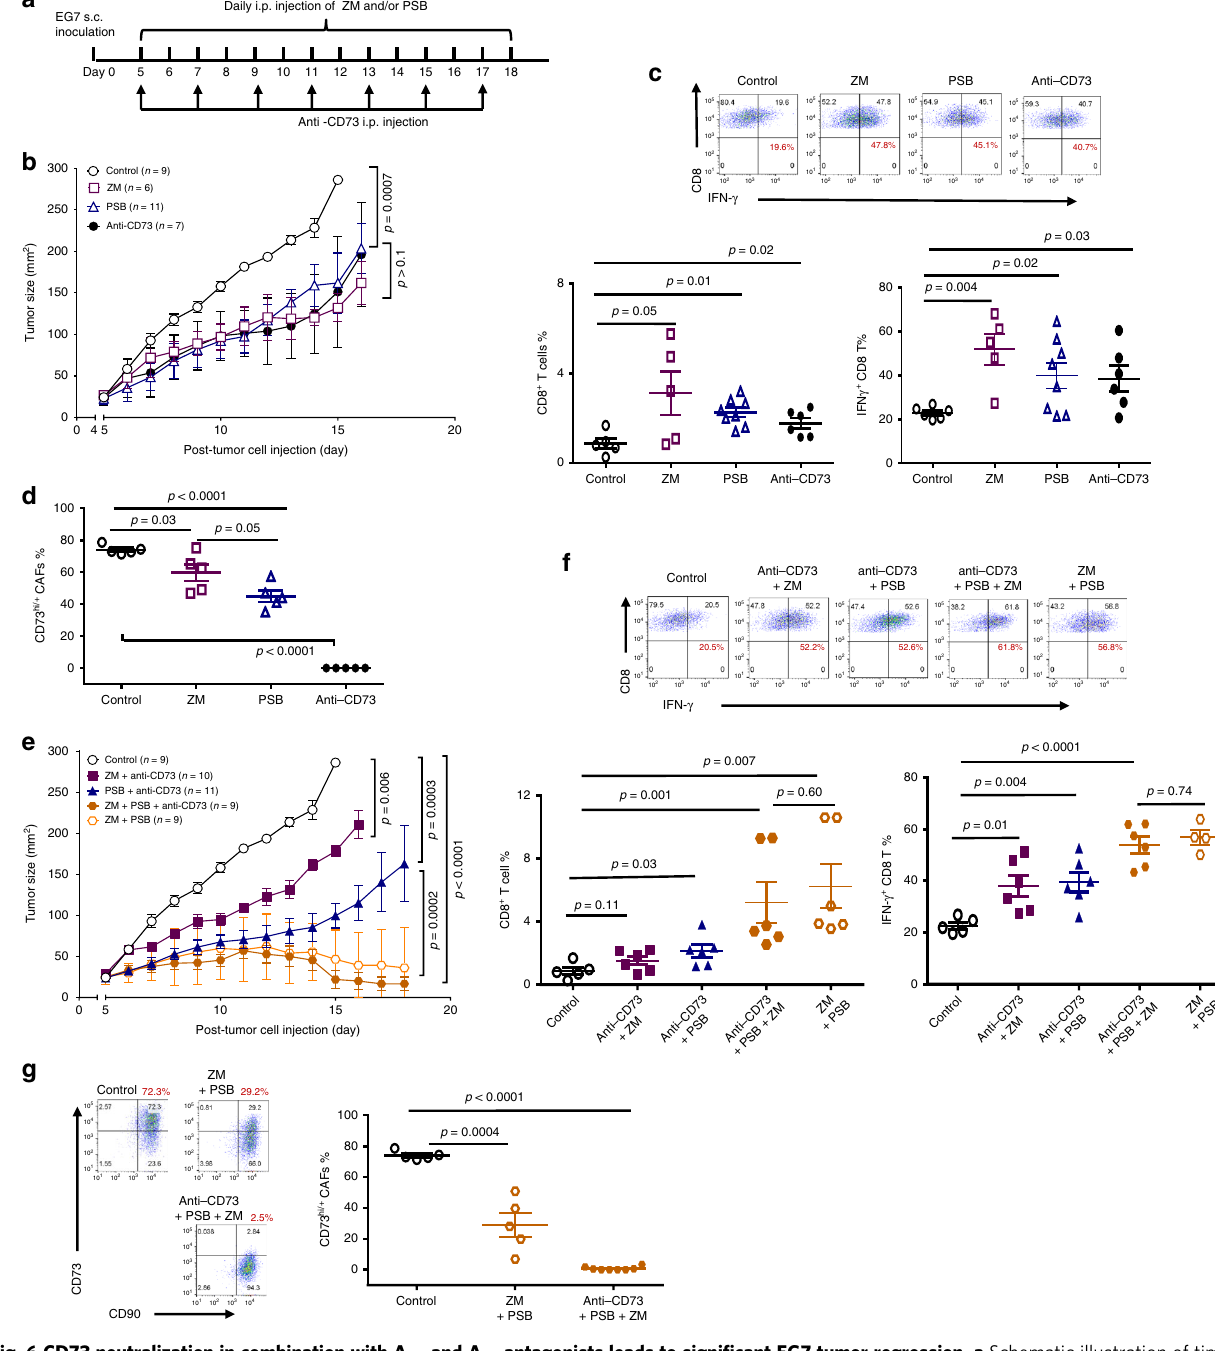
Fig. 6 CD73 neutralization in combination with A 2A and A 2B antagonists leads to signi fi cant EG7 tumor regression. a Schematic illustration of timeline and treatments of EG7-bearing WT mice with daily i.p. injection of 1 mg kg − 1 body weight of A 2A antagonist ZM241385 or A 2B antagonist PSB1115 with or without anti-CD73 treatment. b Tumor progression was examined every day. c The percentage of TIL-CD8 T cells in the EG7 TME and IFN-g-producing CTLs were determined via FACS and summarized. d The percentage of CD73 hi/ + CAFs in the TME following different treatments were analyzed via FACS. e EG7-bearing mice were treated with daily i.p. injection of combined ZM and PSB with or without anti-CD73. Tumor progression was monitored every day. f The percentage of TIL-CD8 T cells and IFN-g-producing CTLs in the EG7 TME were analyzed via FACS. g The percentage of CD73 hi/ + CAFs in the TME of various treated groups were analyzed via FACS. b , e p values were determined via multiple t -tests where the tumor sizes at each time point were compared. c , d , f , g Error bars depict mean ± SEM. p values were determined via two-tailed unpaired Student ’ s t -test. All experiments were repeated at least two times. Source data are provided in the Source Data fi